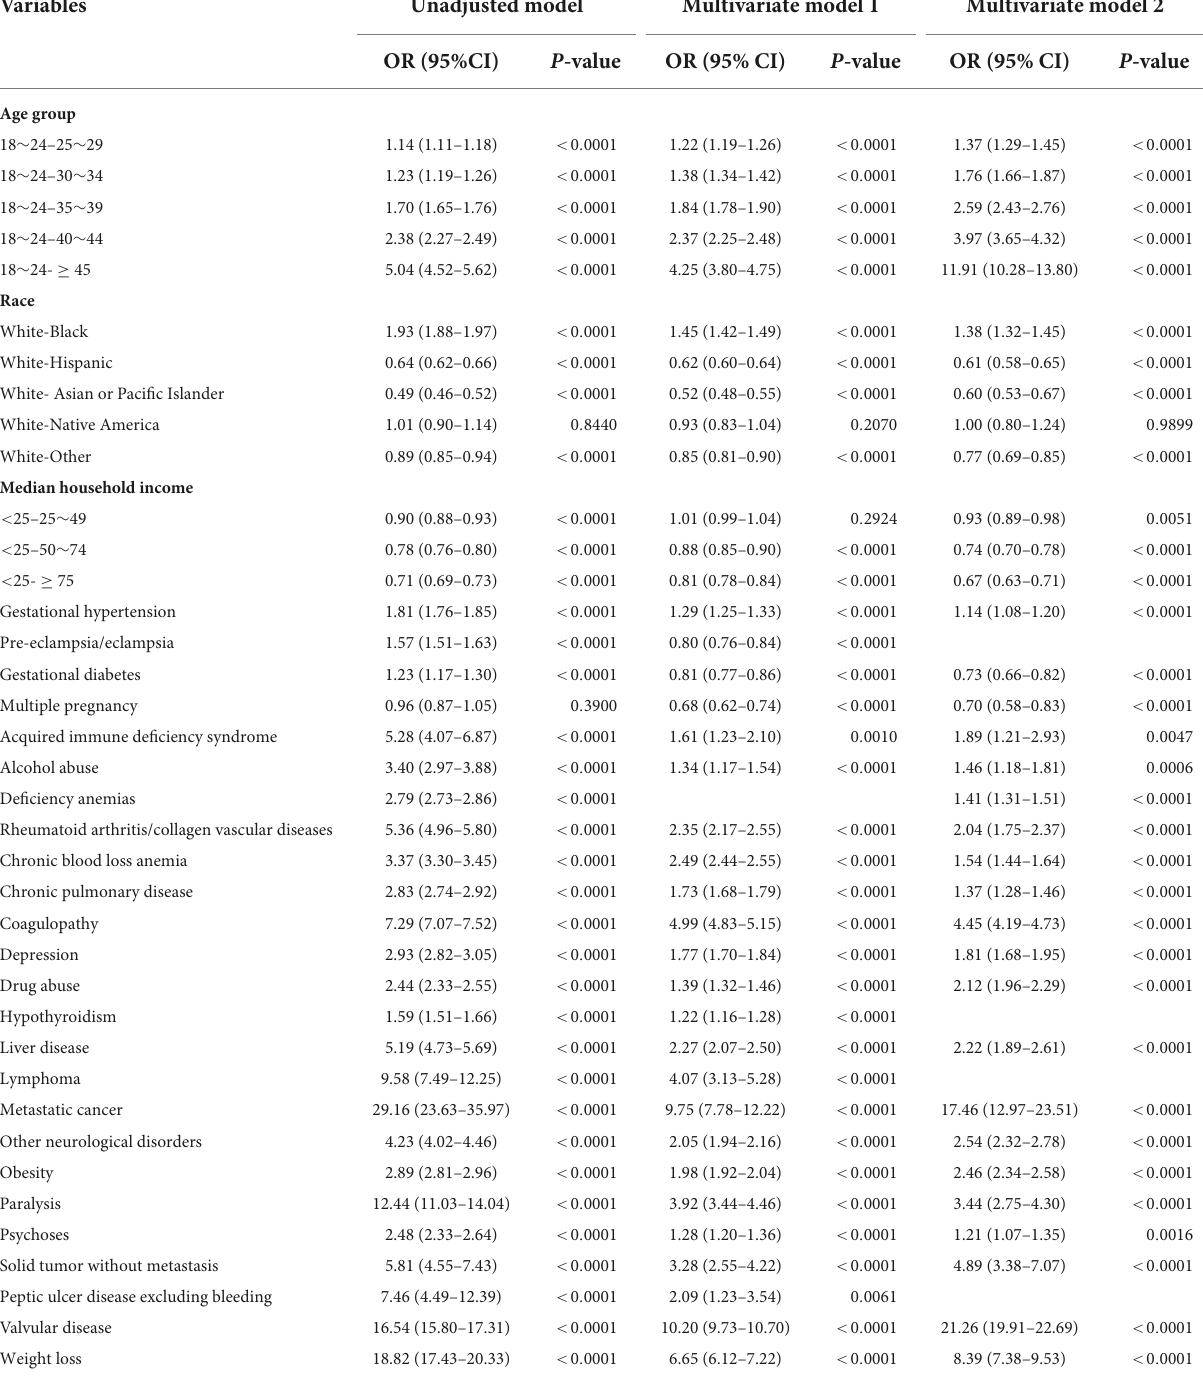
TABLE 2 Association of clinical factors with acute high-risk chest pain diseases during pregnancy and